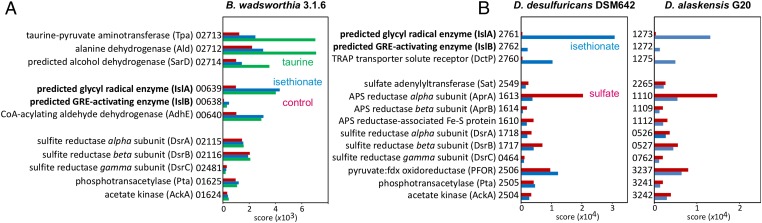
Proteomics experiments with cell-free extracts reveal a putative desulfonating GRE. (A and B) Proteins encoded by the taurine and isethionate utilization gene clusters, including the predicted isethionate GRE (IslA) and GRE-activase (IslB) components, are specifically and strongly expressed during growth with taurine (B. wadsworthia) and isethionate (B. wadsworthia, Desulfovibrio strains). Constitutively expressed proteins for, for example, sulfite reduction (Dsr) and metabolism of acetyl-CoA (Pta and AckA), are shown for comparison. IMG locus tag numbers are given; their prefixes are shown in Fig. 1C. Shown are results of representative total proteomic analyses replicated at least twice with extracts prepared from independent growth experiments.